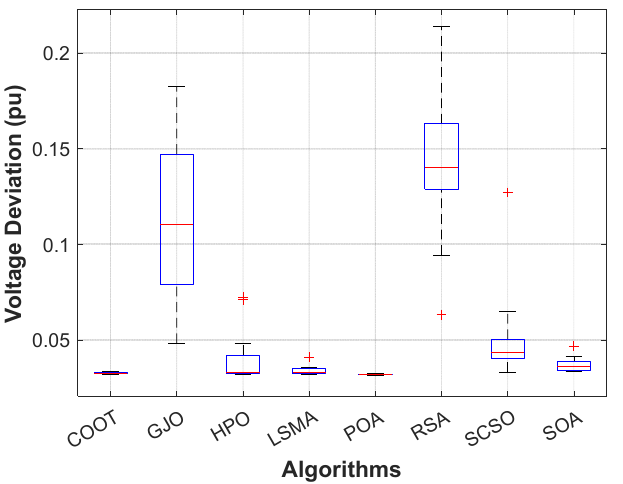
Figure 11. Boxplot of POA and other compared algorithms for case 3 in a standard IEEE 14-bus test system.